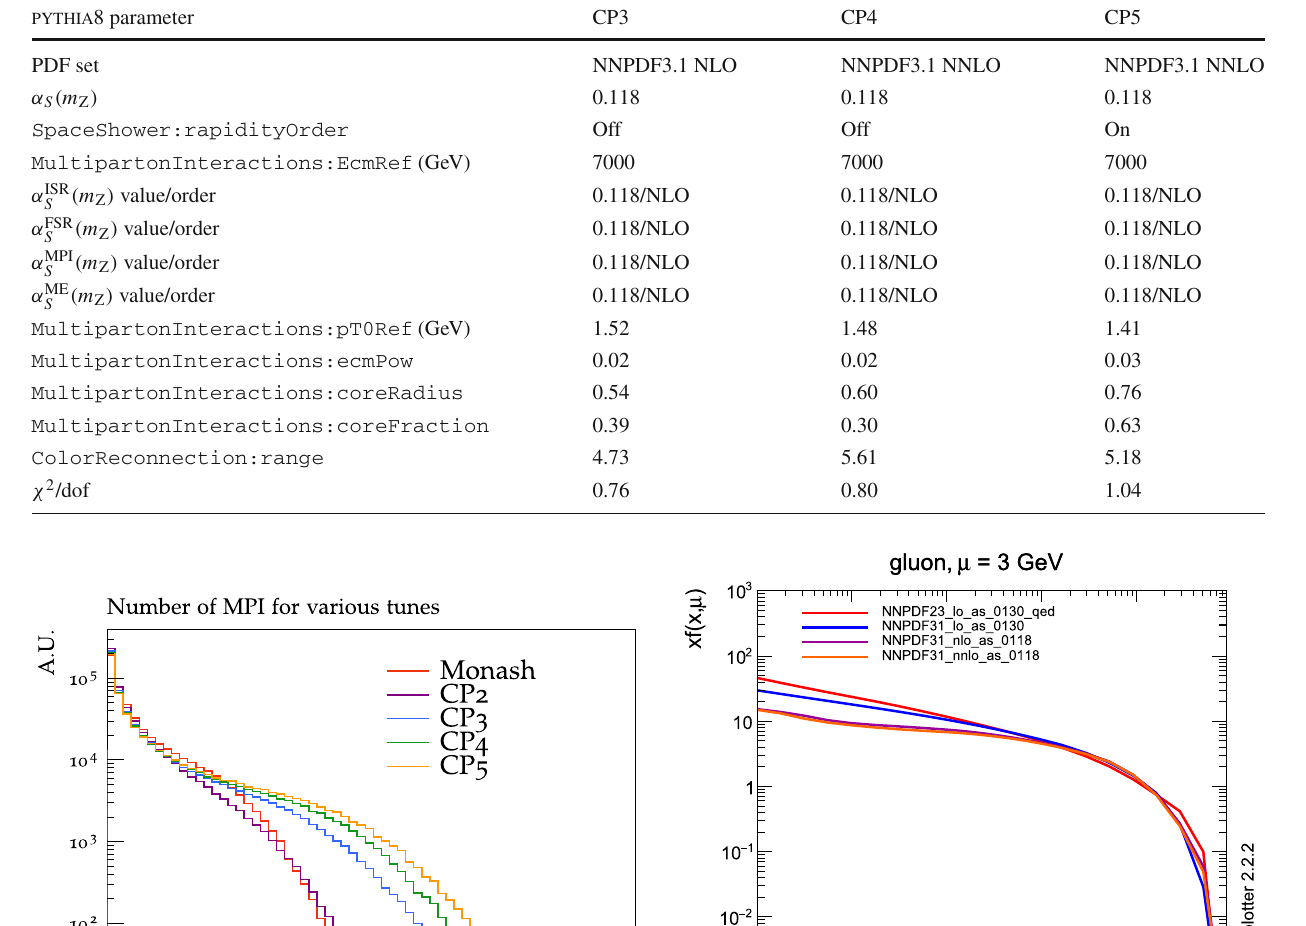
Table 3 CMS pythia 8 NLO-PDF tune CP3 and NNLO-PDF tunes CP4 and CP5. Both the values at Q = m Z and the order of running with Q 2 of the strong coupling α S are listed. In these tunes, we use the